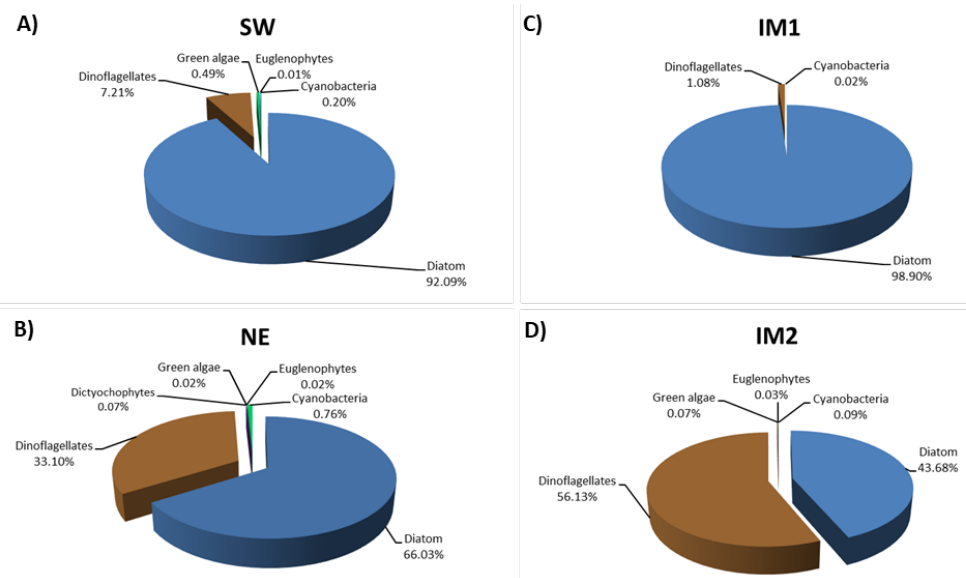
Figure 6. Seasonal contributions of different major phytoplankton groups (mean %) in the Sangga Kechil estuarine-mangrove area during ( A ) the dry season-SW: southwest monsoon, and ( B ) wet season – NE, northeast monsoon, and during the transitional intermonsoon periods ( C ) IM1 (October) and ( D ) IM2 (April).